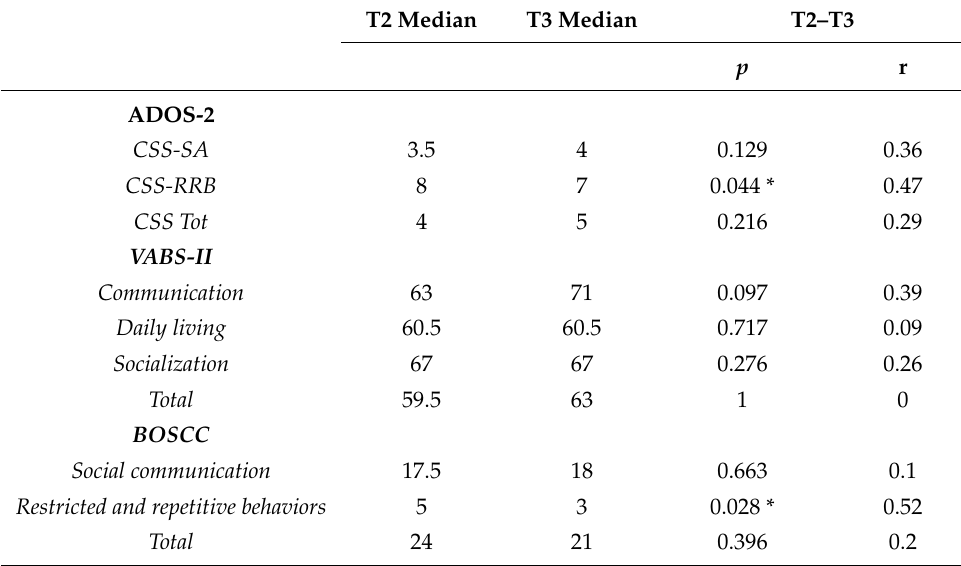
Table 3. Median scores of sample patients in T2 and